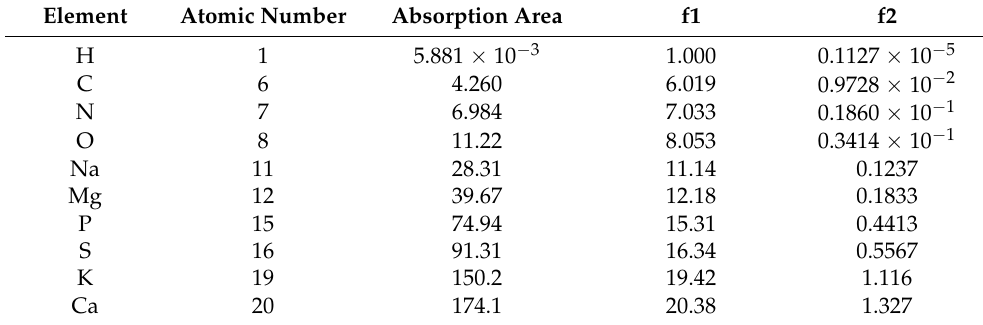
Table 1. X-ray properties of selected elements under 8-keV X-ray. f1 describes the phase shift, f2 describes the absorption.